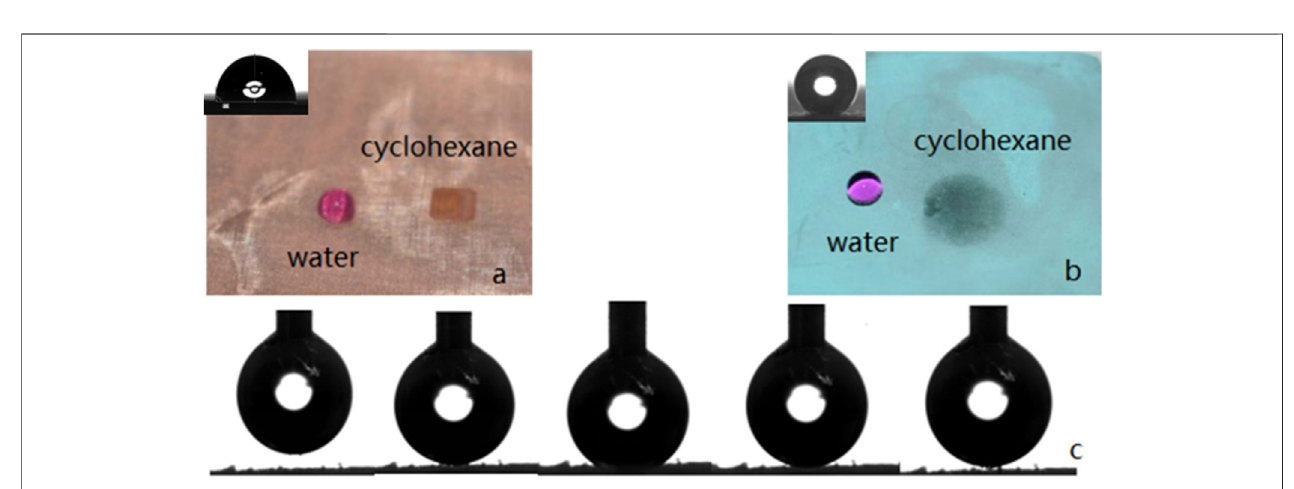
FIGURE 7 | (A) The surface of the untreated copper mesh. (B) The surface of the treated copper mesh. (C) The movement of water droplets on the surface of the copper mesh.